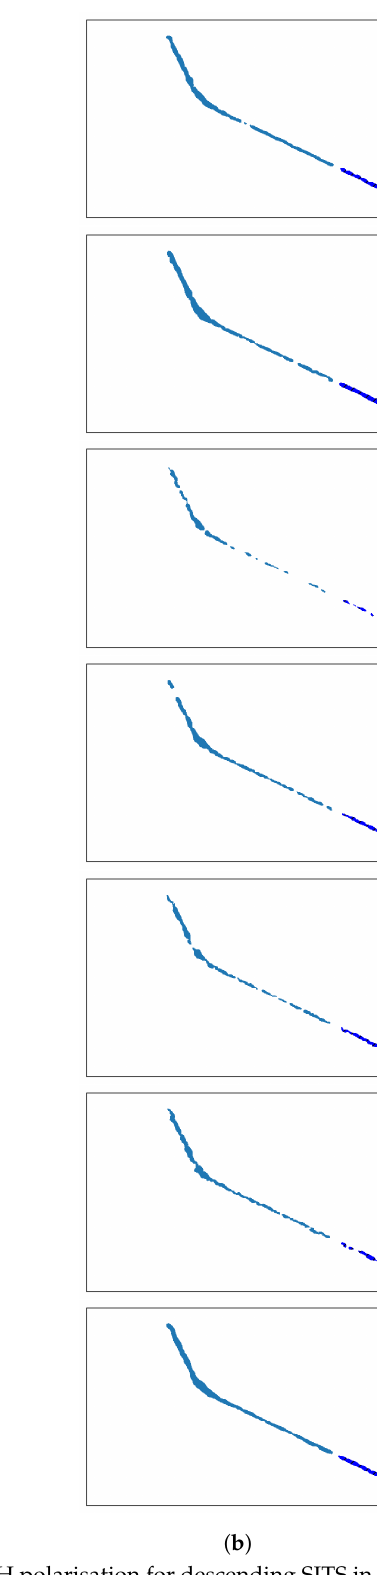
Figure 14. ACM segmentation for VV versus VH polarisation for descending SITS in the static zone. ( a ) Descending VV. ( b ) Descending